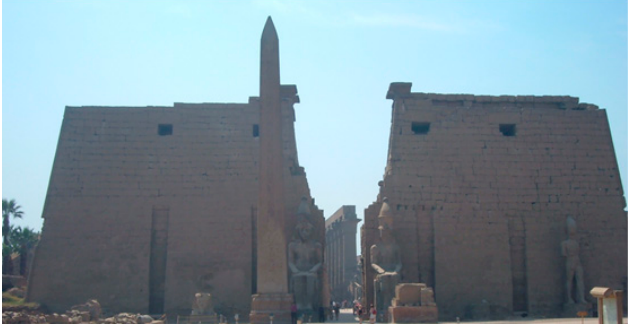
Figure 2. The main façade of Karnak temple at east Luxor.